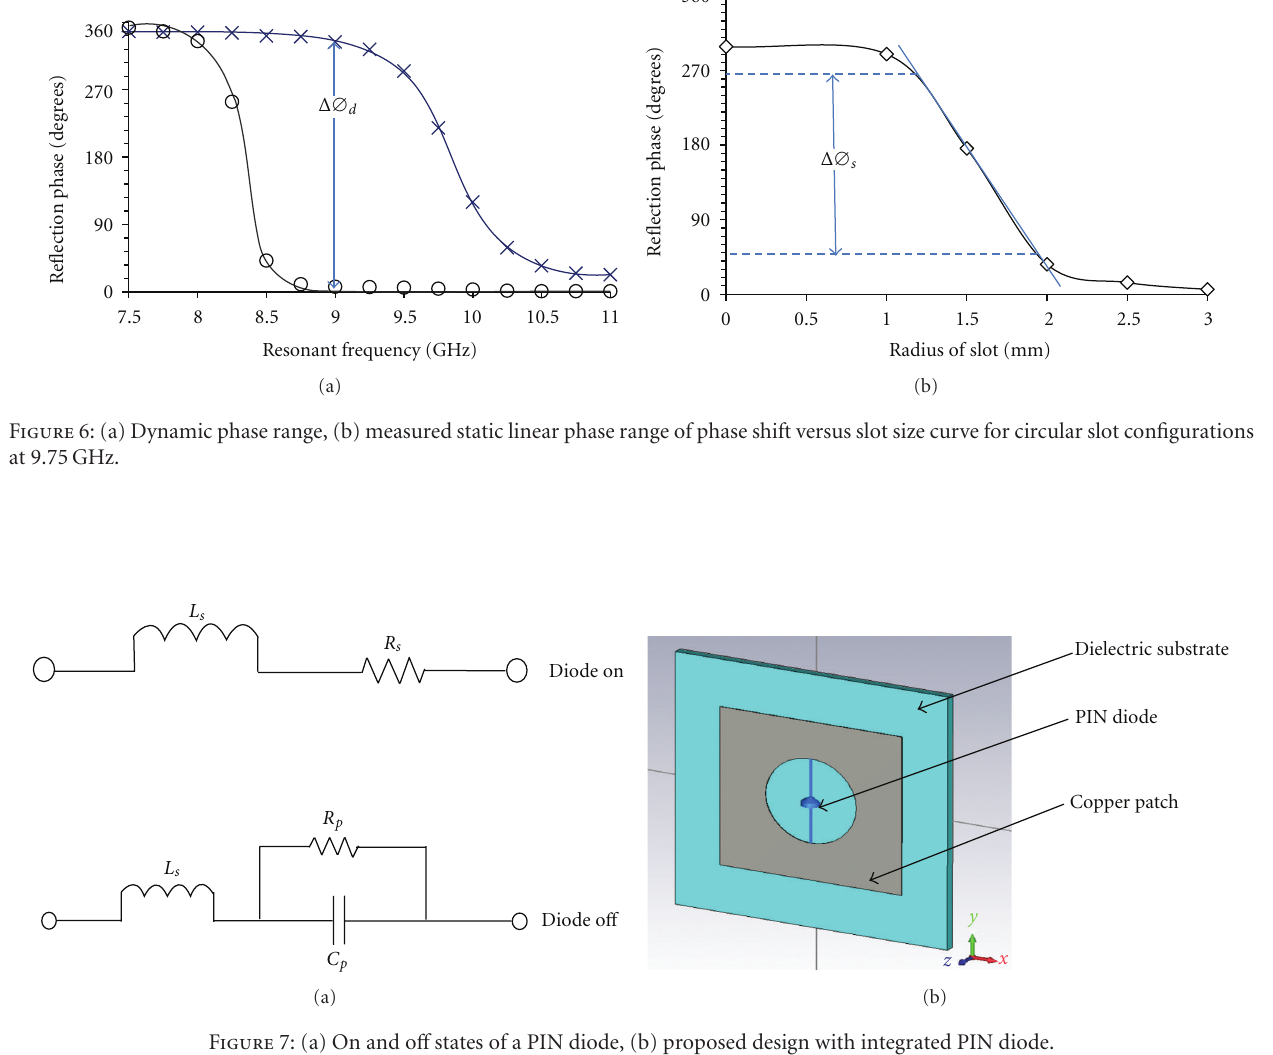
Figure 7: (a) On and o ff states of a PIN diode, (b) proposed design with integrated PIN